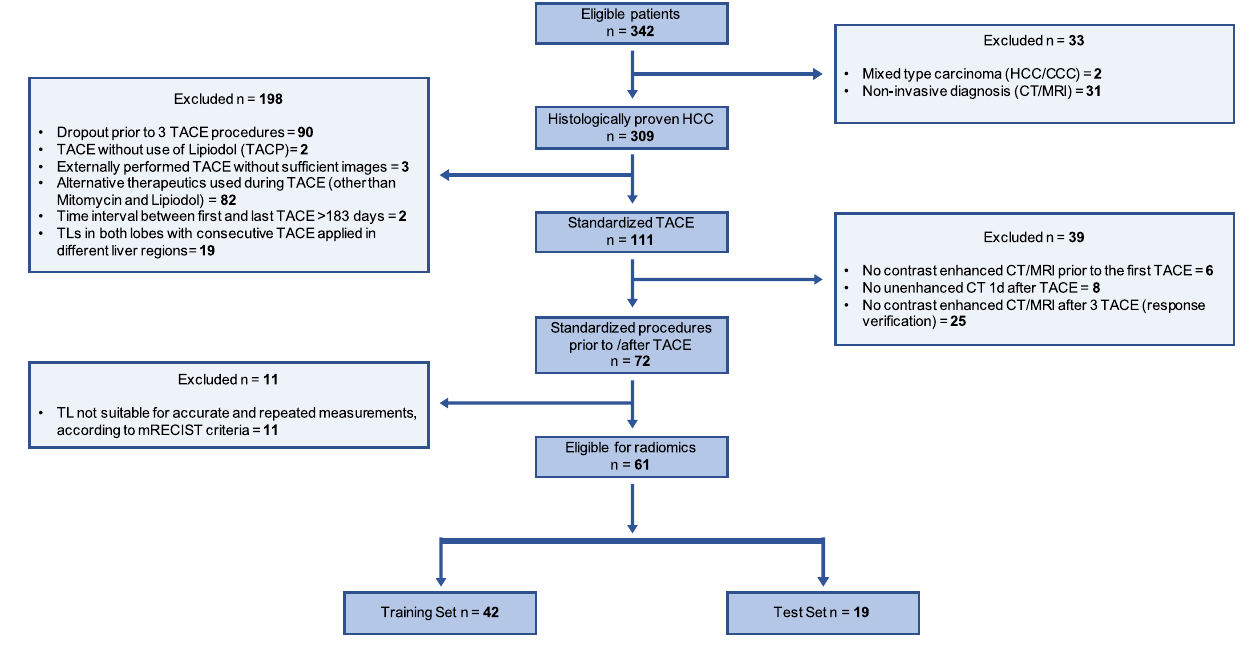
Figure 1. STARD Flowchart of patient inclusion into the study. STARD, Standards for Reporting Diagnostic Accuracy